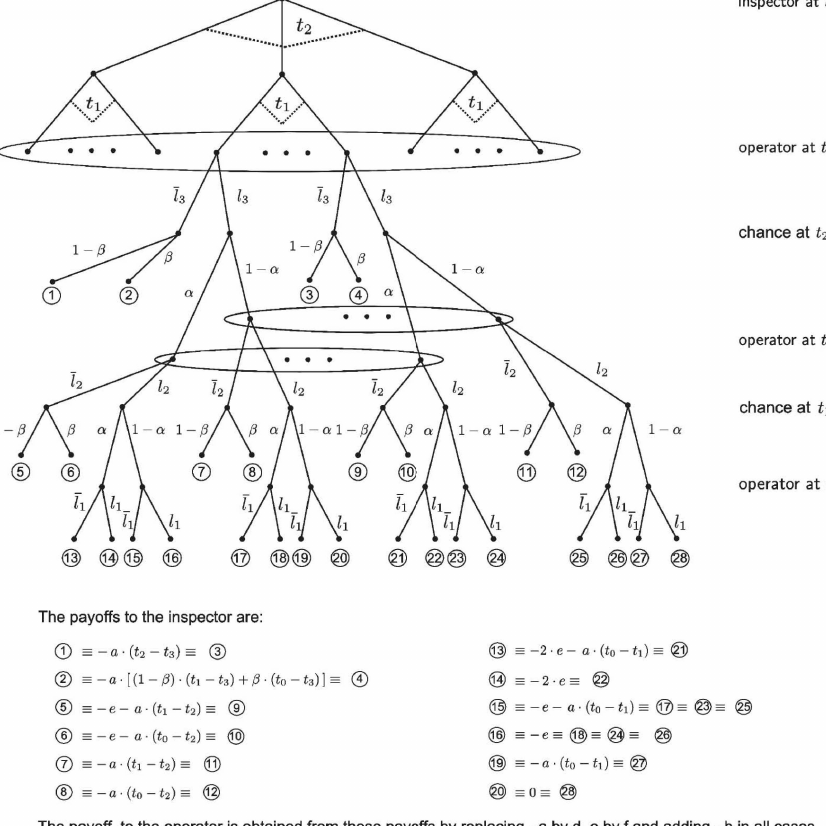
Figure 1. Graphical representation of the extensive form of our hybrid-sequential inspection game with two inspections and the possibility of errors of the first and second kind, i.e., α > 0 and β >